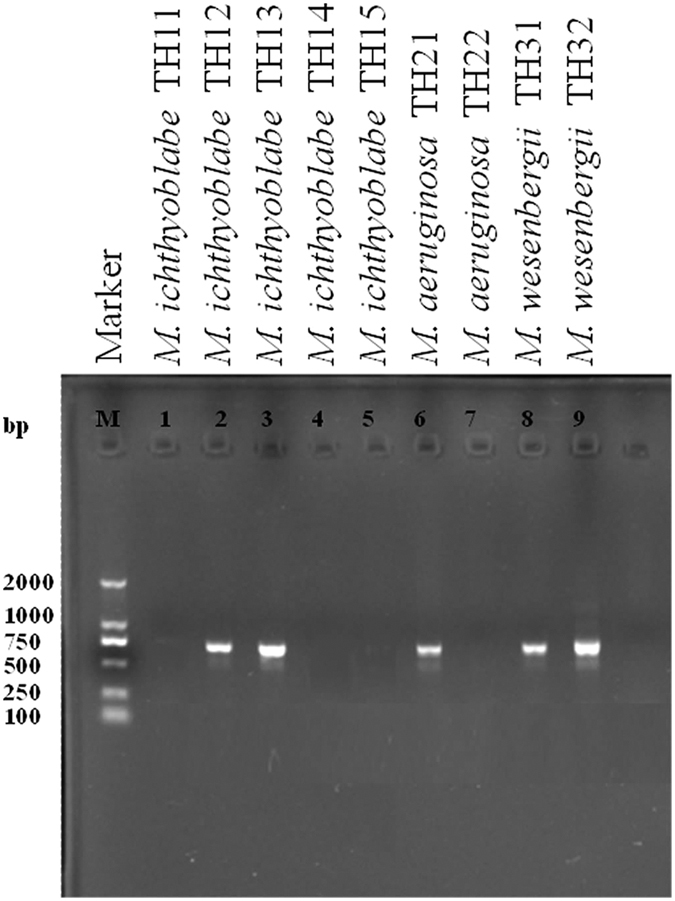
Electropherogram of the PCR products with the primer of mcyB.